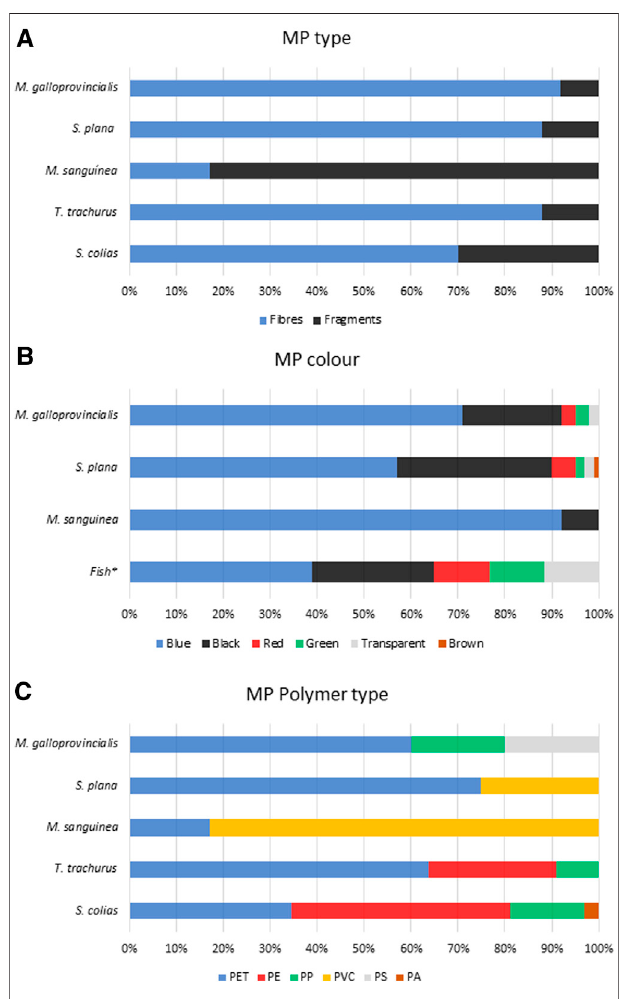
FIGURE 3 | Microplastics (type (A) , color (B) , and polymer type (C) ) found in fi sh, mussels, clams and polychaetes from the Portuguese coast (* pooled